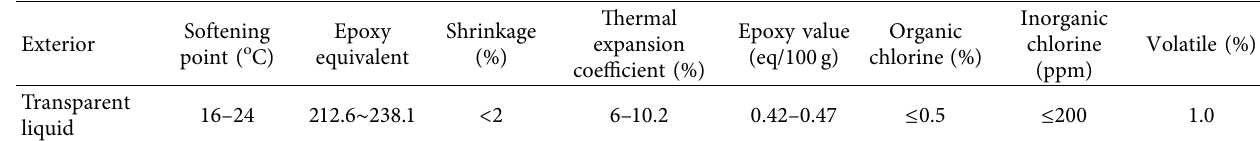
Figure 1: Three components of epoxy-emulsified asphalt. (left: emulsified asphalt for fog seal layer; middle: water-based epoxy resin emulsion; right: water-based curing Table 1: Technical properties of E-44 epoxy resin.